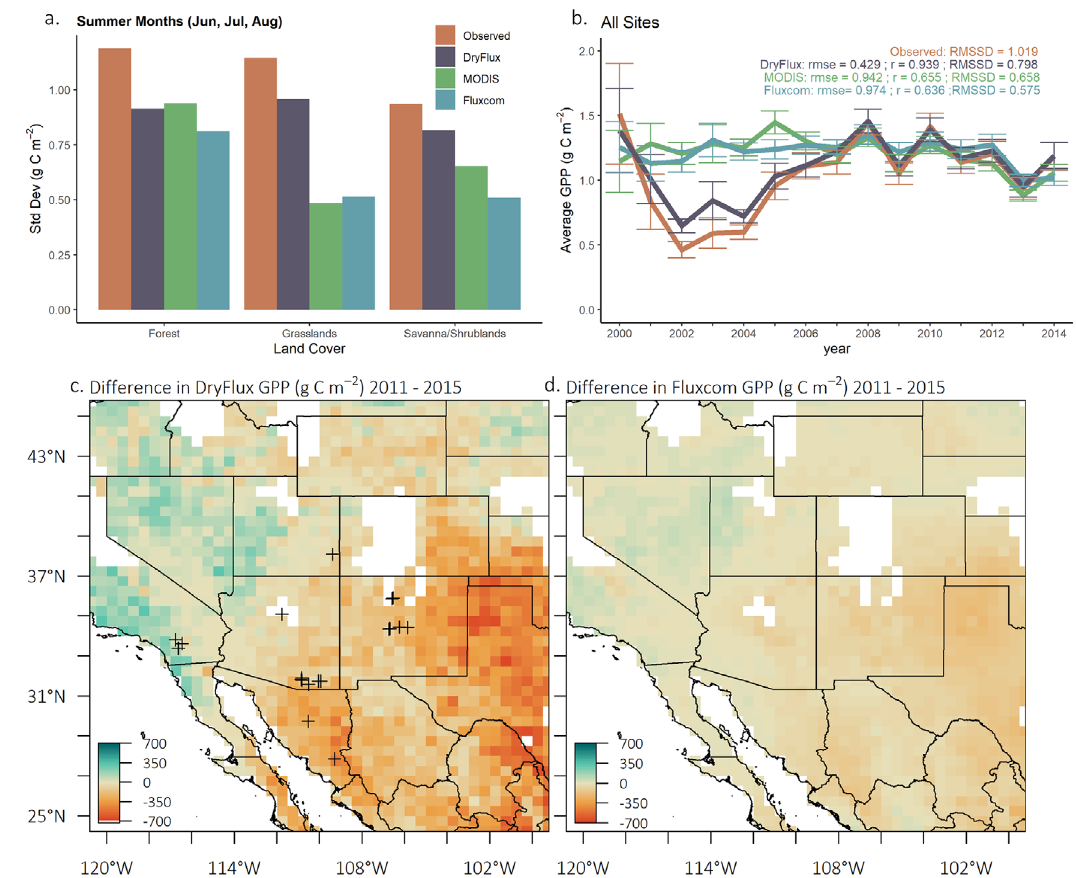
Fig. 2 Relationships between hydroclimate, seasonality, ecosystem type, and IAV in estimated GPP. a Summer interannual variability (IAV), represented by the standard deviation around the long-term (2000 – 2016) GPP mean (gCm − 2 ) pooled for forest, grassland, and savanna/shrubland sites. Bars represent: observed (brown), DryFlux (dark gray), MODIS (green), and FLUXCOM GPP (teal). b Differences in interannual GPP (in gCm − 2 day − 1 ) across all sites. Lines represent: observed (brown), DryFlux (dark gray), MODIS (green), and FLUXCOM GPP (teal). Differences in estimated annual GPP (gCm − 2 year − 1 ) at 0.5° resolution between 2011 and 2015 in ( c ) the DryFlux and ( d ) FLUXCOM models. Southwest fl ux tower sites used in DryFlux model building and testing are symbolized as crosses on ( c